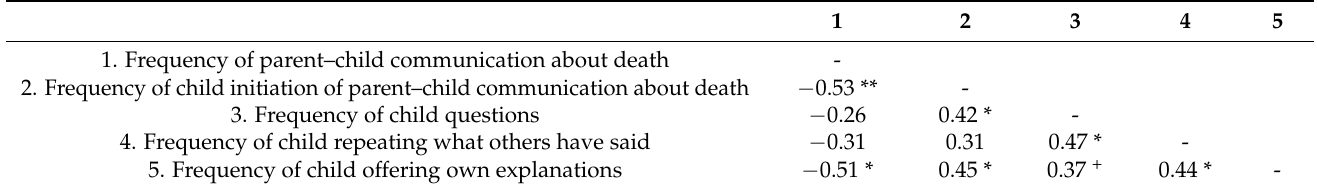
Table 3. Correlations among dimensions of parent–child communication about